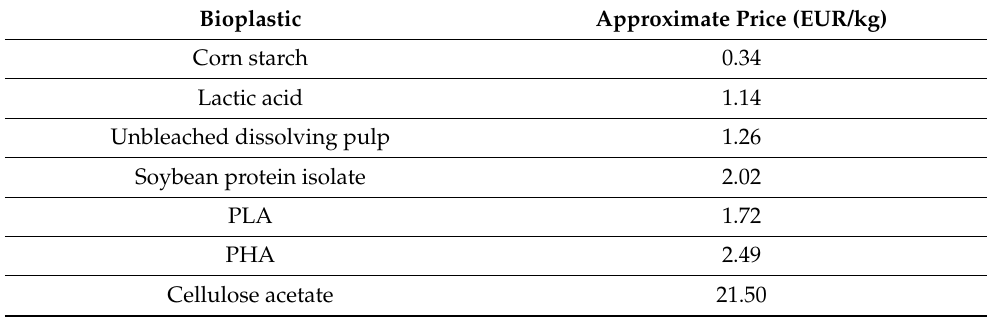
Table 4. Bioplastics and raw material prices (2018). Adapted from “Green Bioplastics as Part of a Circular Bioeconomy”, Trends in Plant Science, vol. 24, no. 3. Elsevier Ltd., pp. 237–249, 1 March 2019